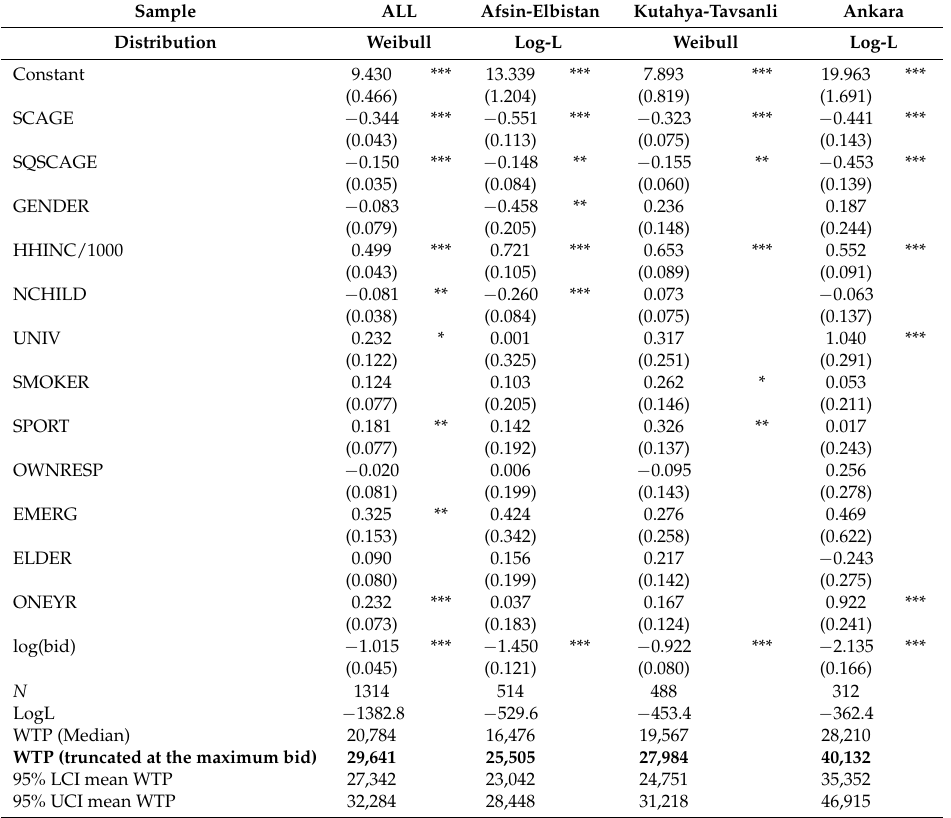
Table 8. Estimated results for Model